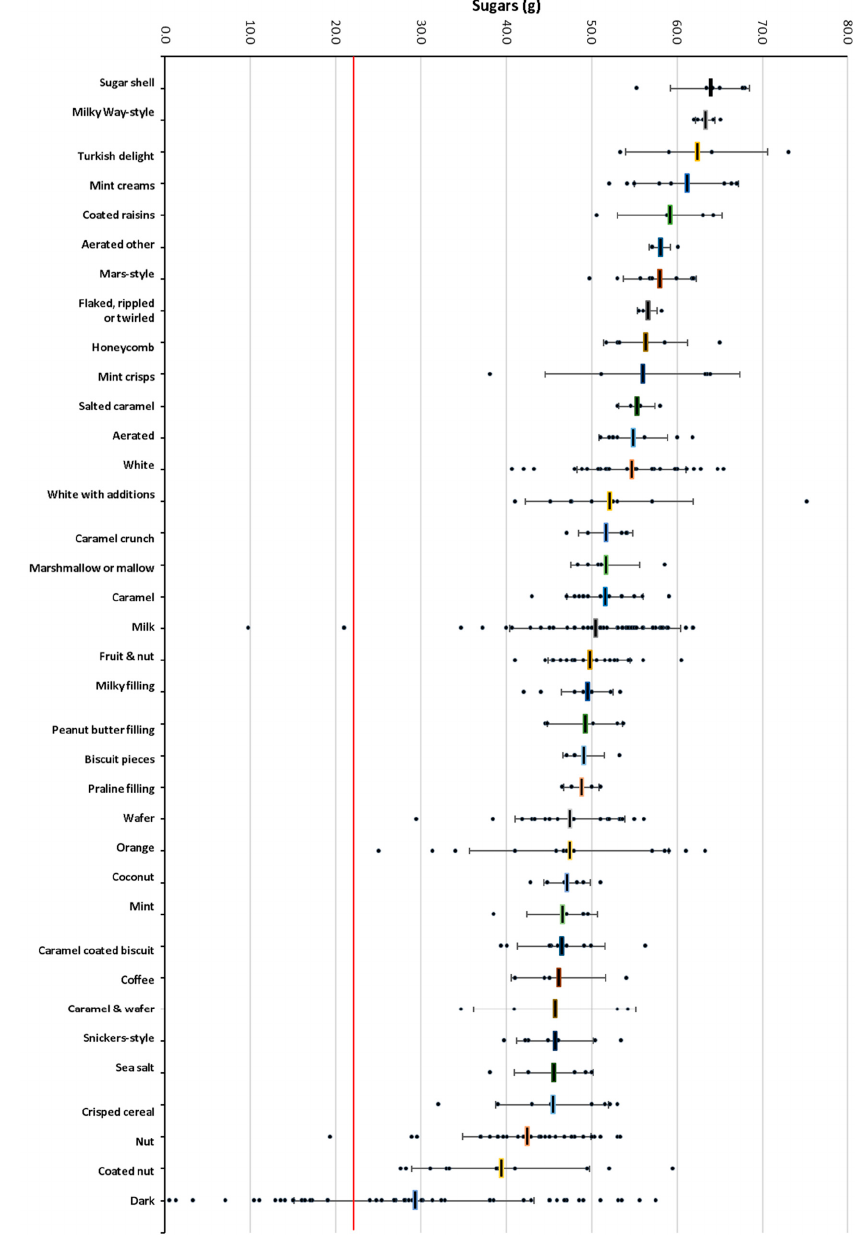
Figure 1. Sugar contents of different categories of chocolate confectionery in 2017 (g/100 g). The red line denotes red (high) criteria for sugar (>11.25 g). Values are individual products within each category (circle) with their means (rectangle) and standard errors represented by vertical bars.